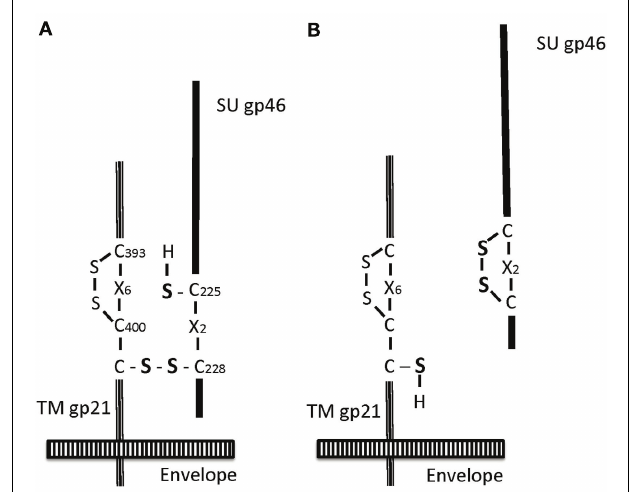
FIGURE 4 | Isomerization of Env proteins. The scheme is shown according to the model by Li et al. (2008), Pinter et al. (1997).The disulfide bond is present between C(228) of SU gp46 and C(401) ofTM gp21 (A) . Upon the isomerization, this bond is cleaved and the new disulfide bond is made between C(225) and C(228) of gp46, leading to SU dissociation and TM translocation (B) .